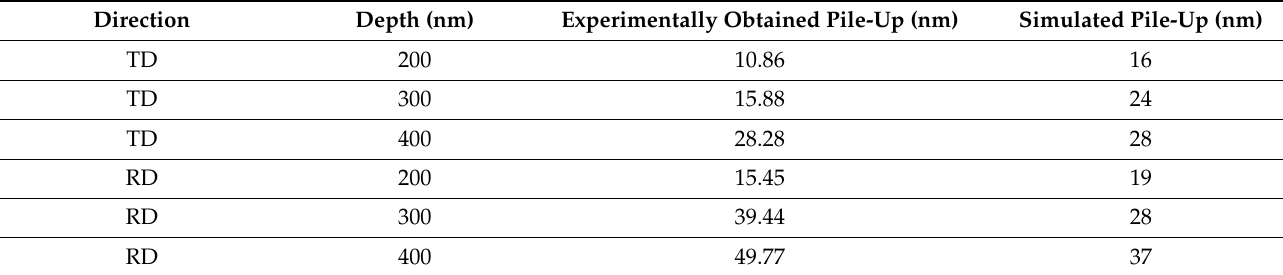
Table 4. Comparison of experimental and simulation pile-up